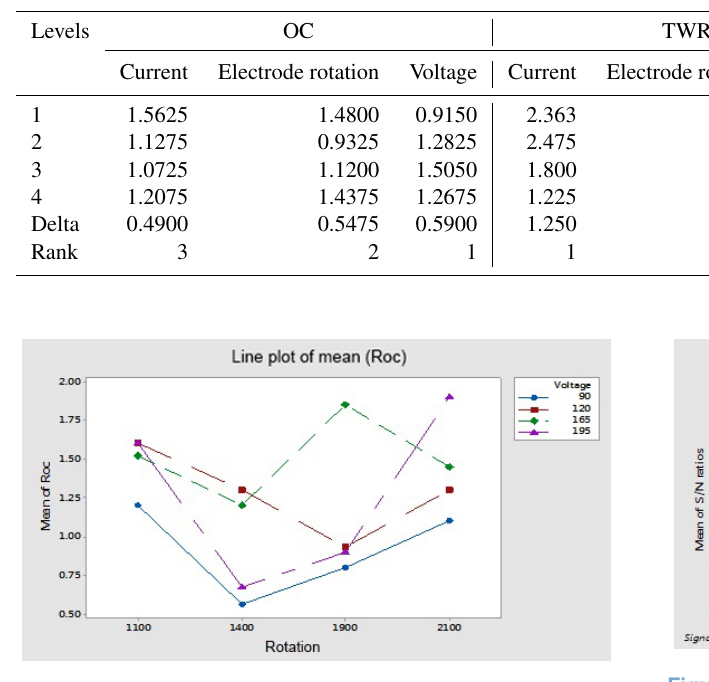
Figure 10. Rotation and voltage relation of OC for the non- cryogenic tool.